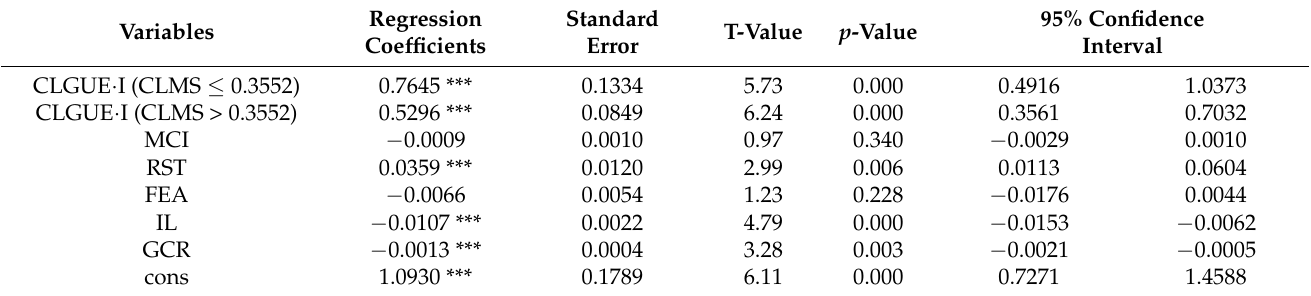
Table 6. Threshold Regression